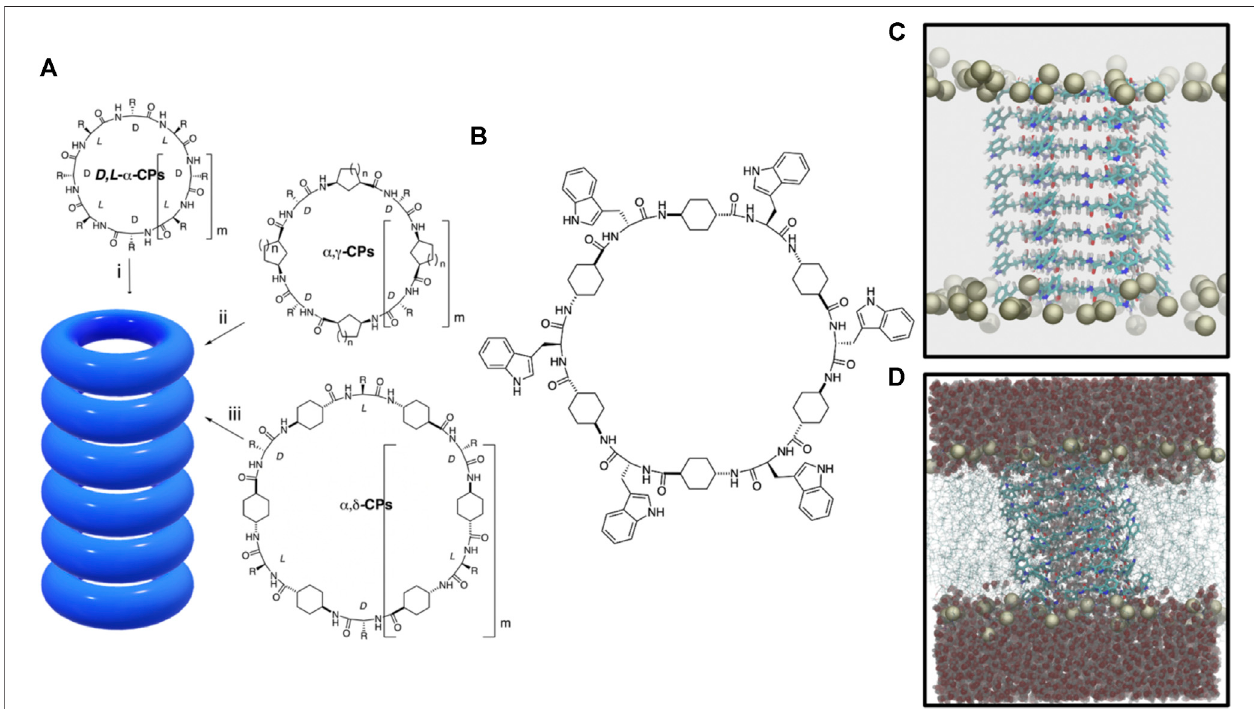
FIGURE1|(A) Peptidenanotubemodelsformedbythestackingofcyclicpeptidesofdifferenttypes:(i) D , L - α -CP,(ii)CPscontaining γ -Acas( α , γ -CPs),and(iii)CPs containing δ -Acas ( α , δ -CPs). (B) c -[( L -Trp- δ -Ach- D -Trp- δ -Ach-) 3 ] CP used in this work. (C) Snapshot of the initial α , δ -SCPN structure for the MD simulation. Only the phosphorous atoms of the lipids are shown. (D) Final structure (t (cid:2) 200 ns) for the blank simulation (without ions), where also the lipid chains and the water molecules are shown.